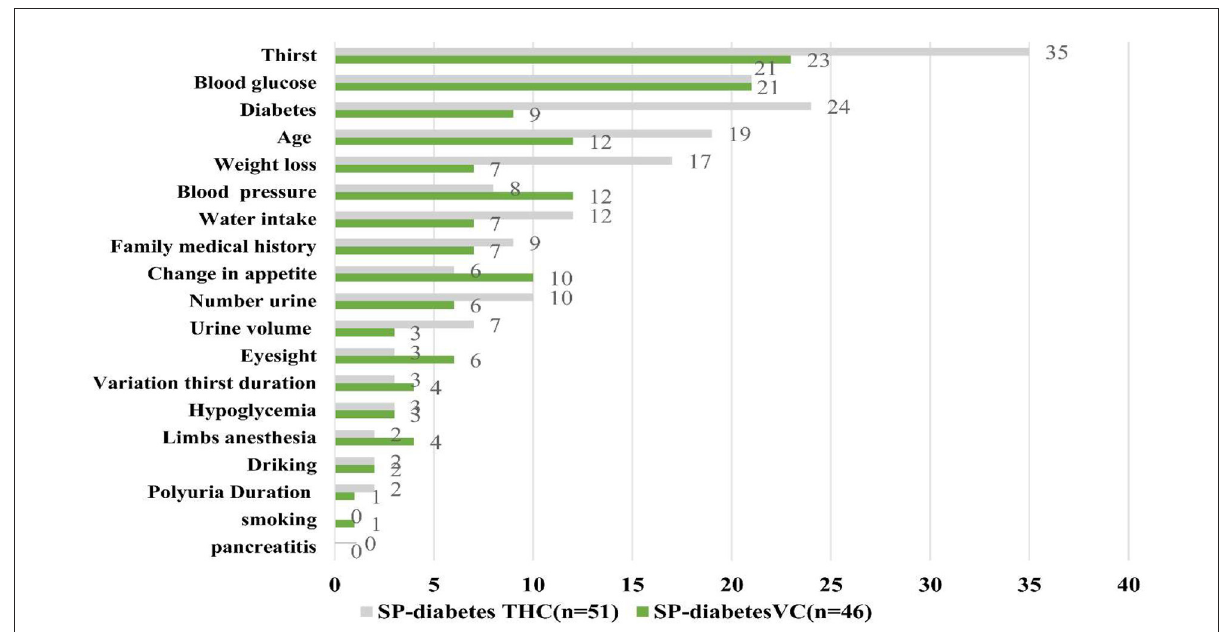
FIGURE1 Adherence to clinical checklist, diabetes